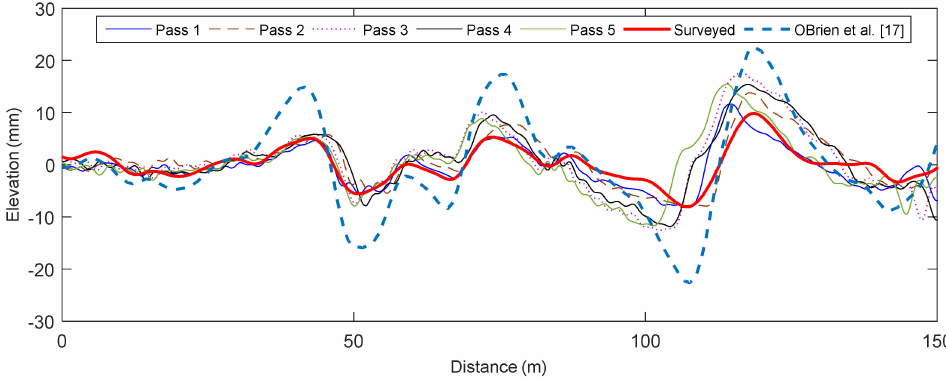
Figure 10. Five passes of BFD and the filtered surveyed (unloaded)